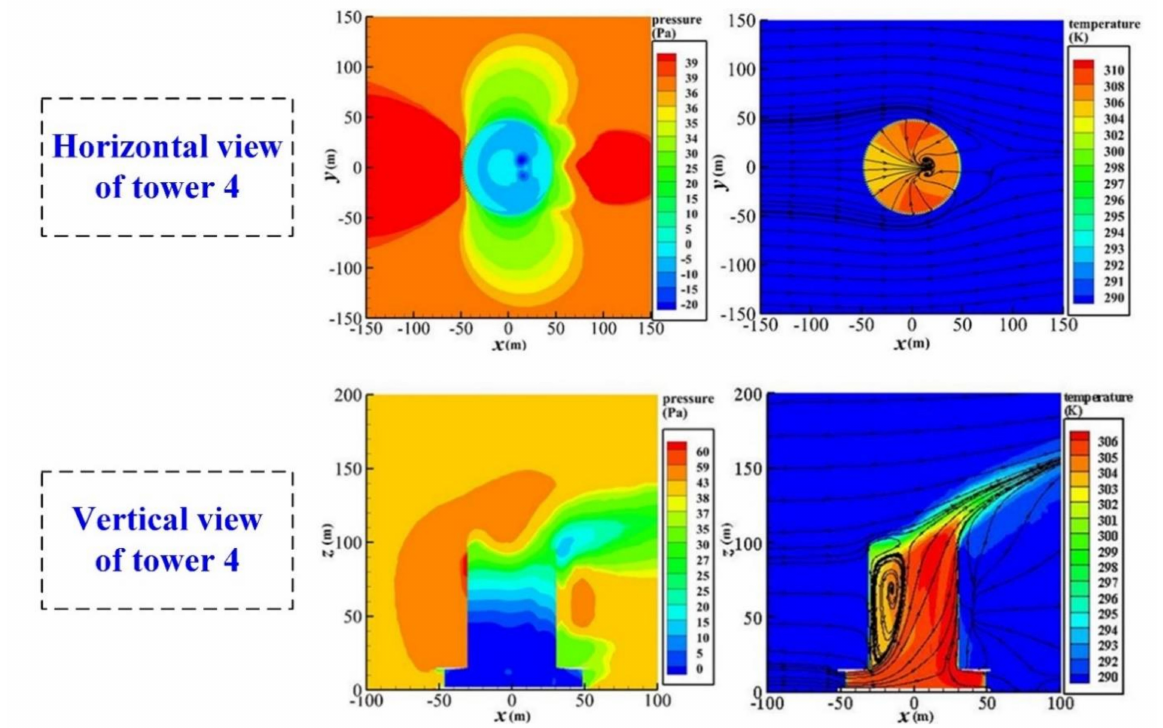
Figure 13. Air variable contours for steel-truss NDDCS with cylindrical tower configuration at design crosswind of 4